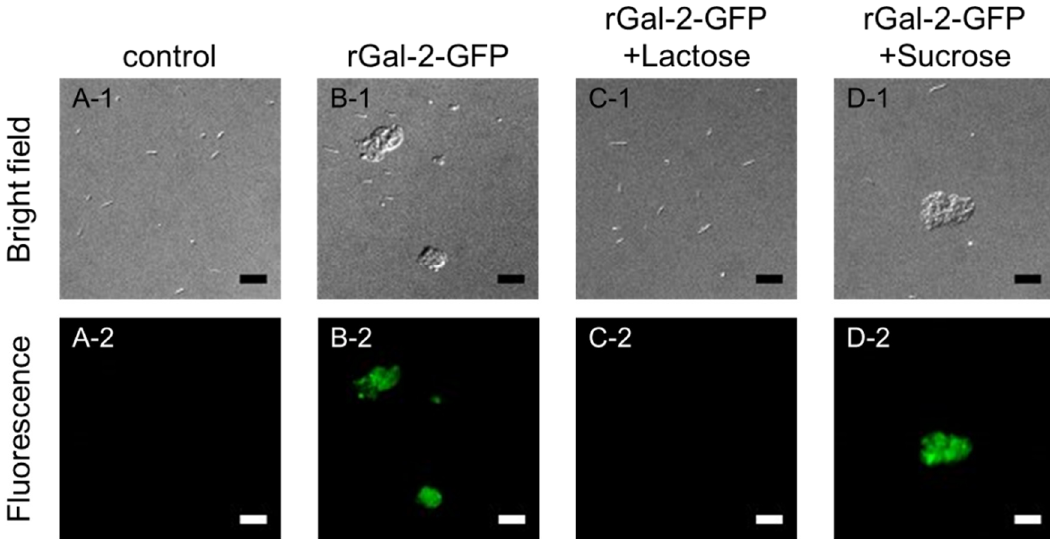
Figure 3. Observation of rGal-2-GFP- H. pylori interaction. ( A ) Control (without Gal-2 and sugars). ( B ) rGal-2-GFP alone. ( C ) rGal-2-GFP with lactose. ( D ) rGal-2-GFP with sucrose. Upper (1) and lower (2) images are transmission and fluorescence images, respectively. The concentration of rGal-2-GFP added was 93.9 µg/mL; concentrations of lactose and sucrose were 0.1 M. Scale bars represent 10 µm.